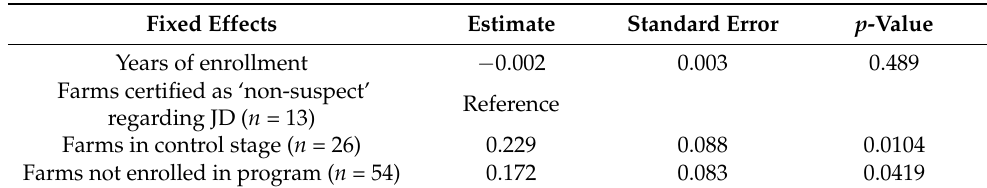
Table 2. Results of the generalized linear mixed-effects model for variables associated with calf mortality.